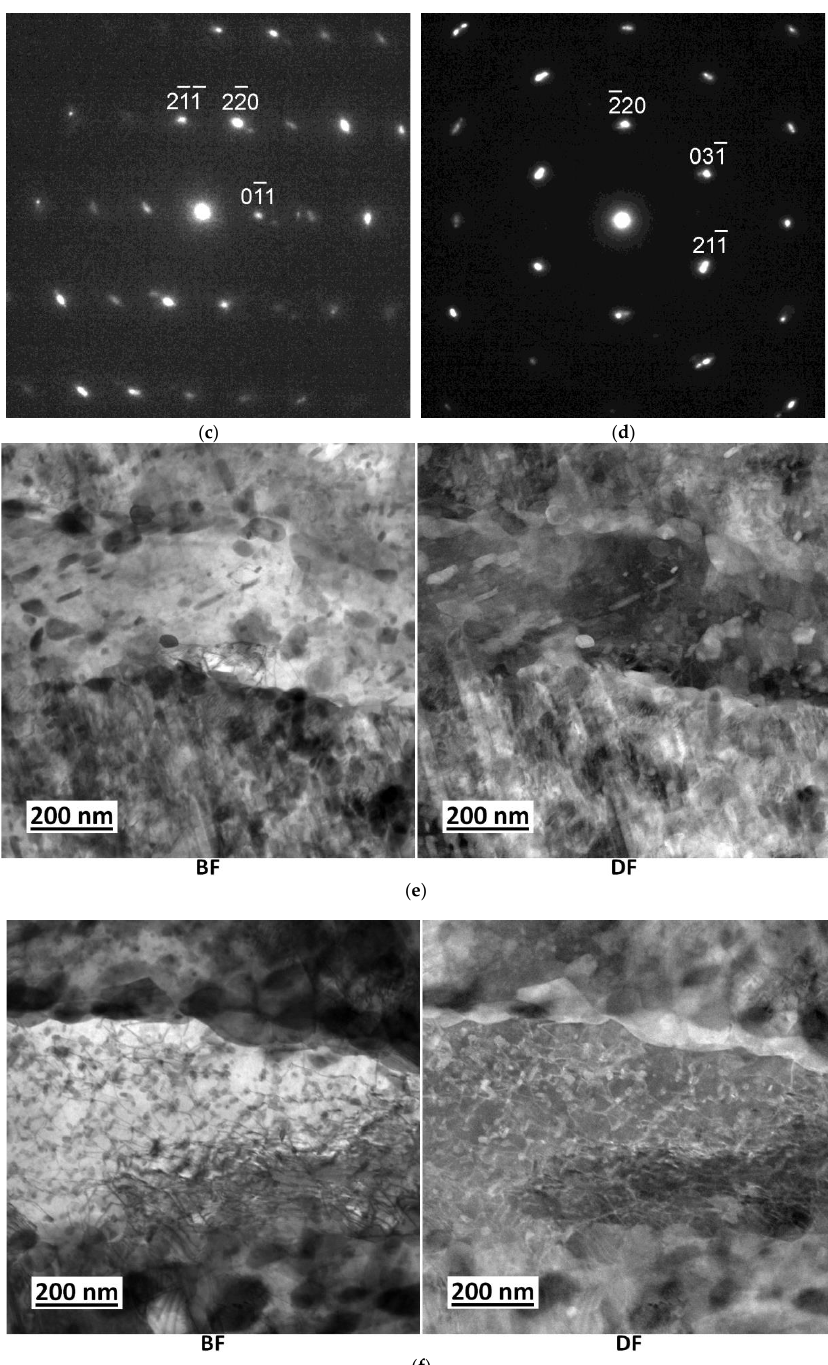
Figure 5. Cementite particles at PAG and martensite packet boundaries in 0 Cu ( a ) and 1.5 Cu ( b ) steel tempered for 24 h and corresponding SAED results of cementite in 0 Cu ( c ) with zone axis [111] and 1.5 Cu ( d ) steel with zone axis [113]. Comparison of density of fine precipitates in microstructure of 0 Cu ( e ) and 1.5 Cu ( f ) steels. A lot of fine precipitates with a size of tens of nanometres arose within the martensitic needles in both steels (Figure 5e,f). As proven by EDS analyses, these fine precipitates were cementite in both materials, and in the 1.5 Cu, there were additionally Cu precipi- tates with a size of about 10 nm. Thus, the density of fine precipitates seems to be higher in the 1.5 Cu sample. The resolution of carbides (cementite) and Cu-precipitates using EDS maps is reliable because the carbides are enriched in chromium and manganese. Cement- ite particles contained, on average, about 7.8 wt.% of Cr and 5.5 wt.% of Mn (balance Fe), according to the EDS analyses of the carbon replicas. An example of the occurrence of Cu particles at the boundaries of martensitic needles is shown in Figure 6a. An EDS map for Cr identifies the cementite precipitates. For comparison, the TEM micrograph in Figure 6b represents a similar EDS map also covering a boundary of a martensitic needle on the 0 Cu sample. Figure 6c demonstrates Cu precipitation occurring at the edge of cementite.